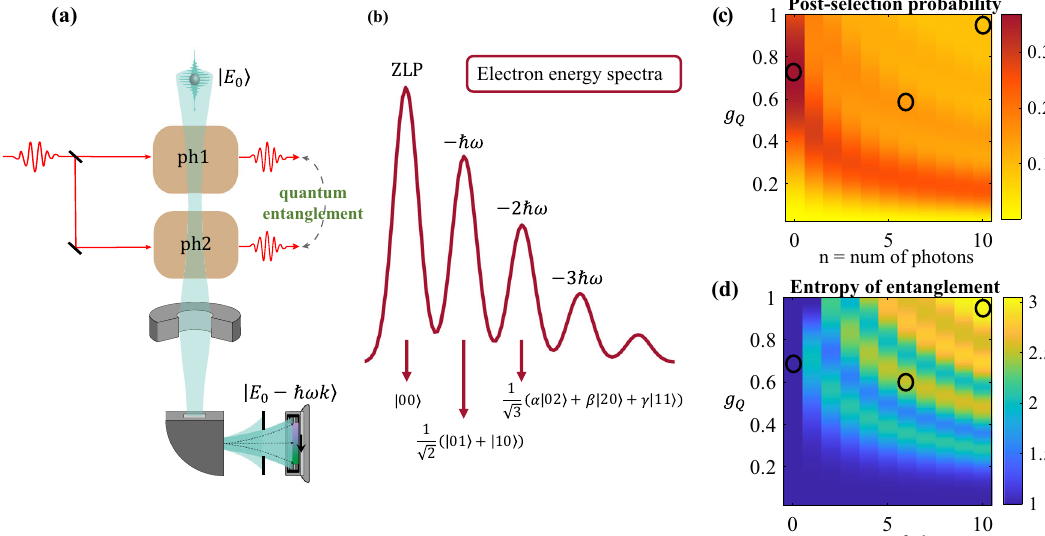
Fig. 4 Inducing photonic entanglement by post-selecting the electron ’ s energy. a A scheme of the proposed experiment, where an (unshaped) electron interacts with two Fock states of light and is then measured with an electron energy spectrometer. The electron spectrometer enables post-selection of events in which an integer number of photons k were emitted by the electron. b Each electron energy is entangled to a different photonic state after the interaction. c A map of the probability to post-select the electron with energy E 0 − ℏ ω (i.e., k = 1) after one interaction for different initial parameters. The x axis is the number of photons in each photonic Fock state. The y axis is the interaction strength g Q . d A map of the entropy of entanglement between the two states of light after post-selecting on electrons with energy E 0 − ℏ ω (i.e., k = 1). The axes are the same as in b . In both panels, we mark interesting initial parameters (one of them is discussed in the text and represents the creation of a Bell